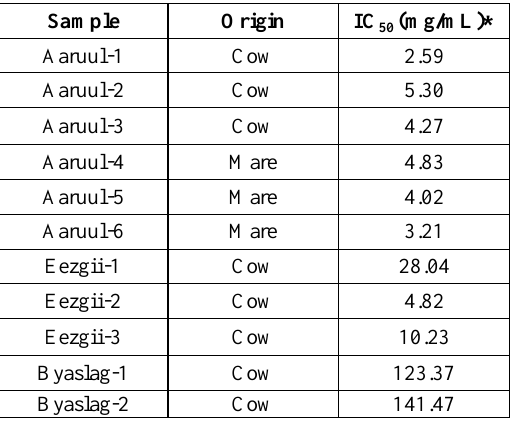
Table 1 . Angiotensin- converting enzyme inhibitory activity of Mongolian traditional milk products Extracts.